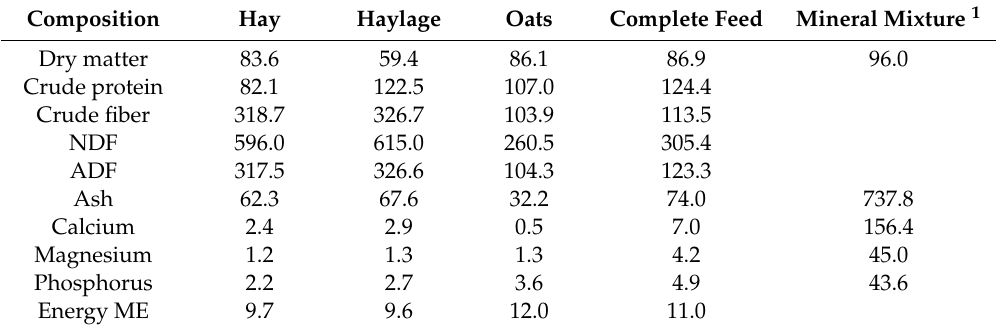
Table 1. Average chemical composition (g / kg DM) and energy value (ME MJ / kg DM) of the experimental